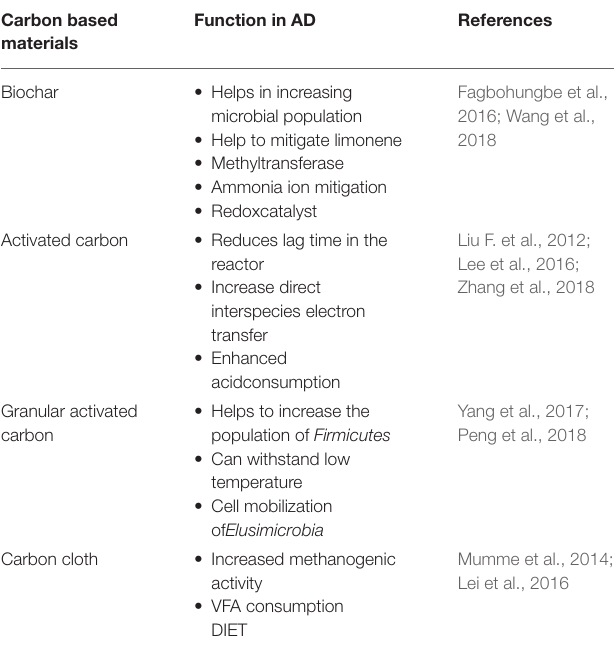
FIGURE 1 | Direct interspecies electron transfer with and without carbon-based functional